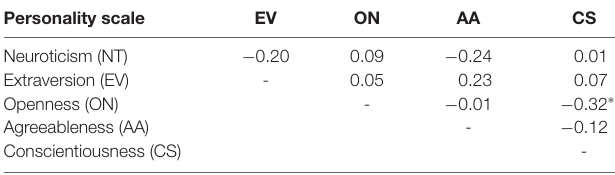
TABLE 3 | Intercorrelations among personality traits measured by NEO-FFI. Personality scale